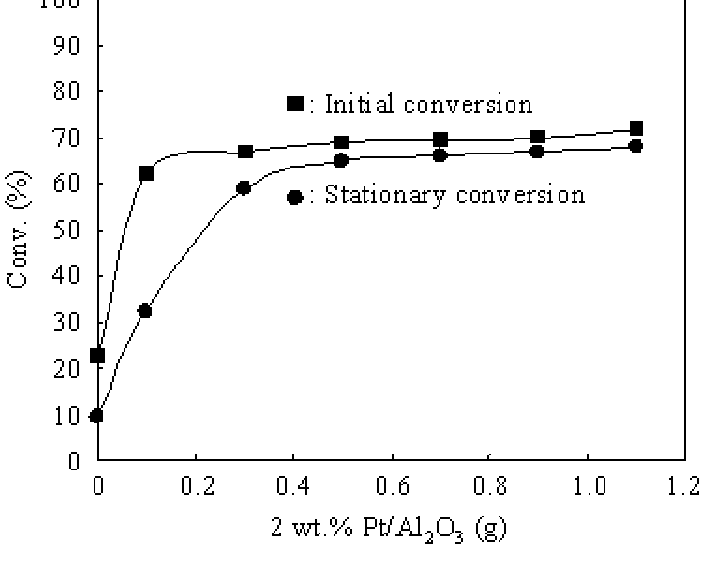
Figure 5. Effect of Pt amount in the Pt/Al n -butane at 573 K. ( ■ ) Initial conversion. ( ● ) Stationary conversion. Cs2.5: 0.5 g.